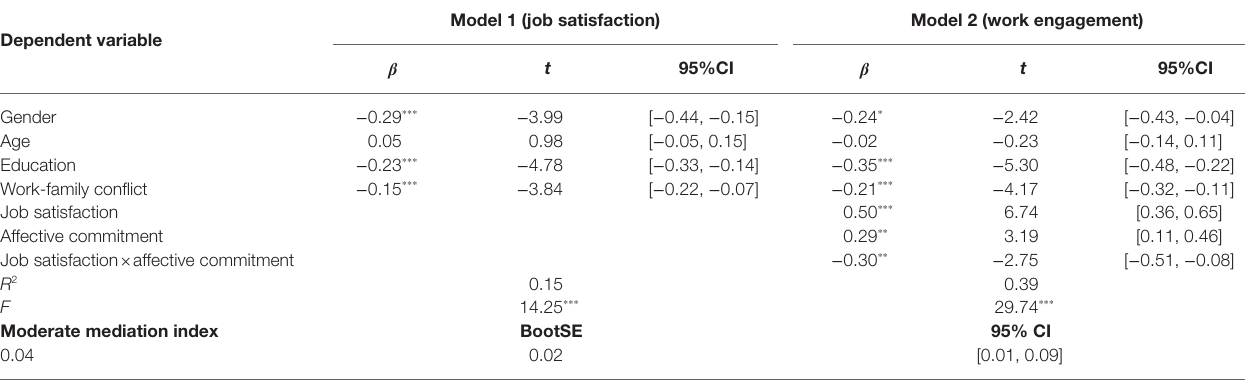
TABLE 4 | Results of affective commitment moderate the mediation process.